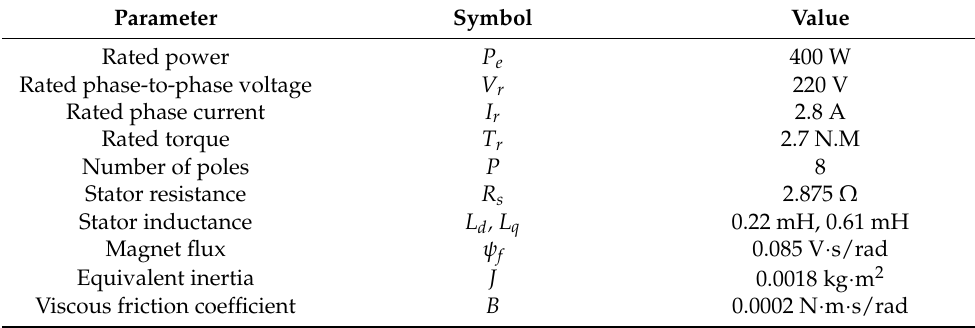
Table 1. Nominal SPMSM